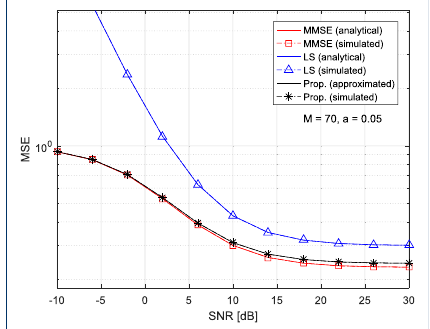
Paragraph under Numerical Results and